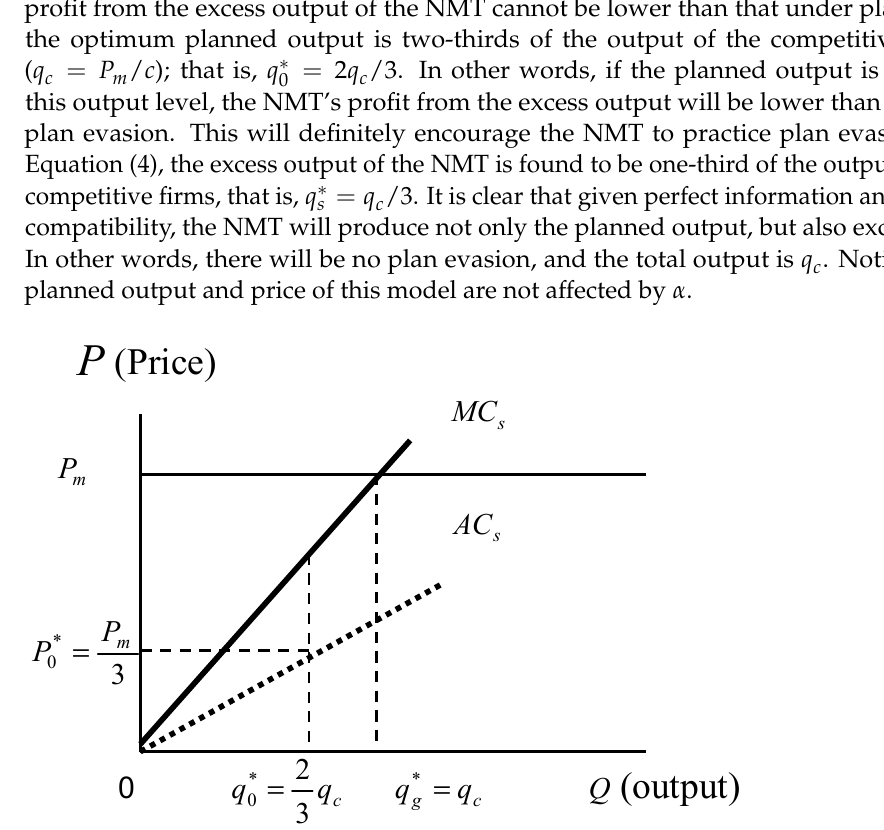
Figure 1. The planned output and the planned price set by the planner when the NMT fulfills the planned quota.